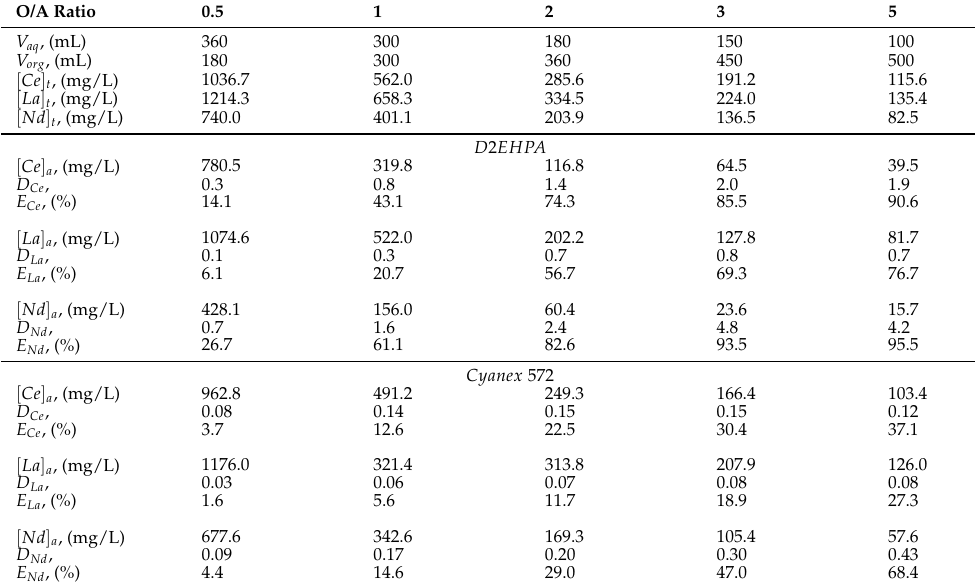
Figure 20. McCabe–Thiele diagrams for the extraction of Ce , La , and Nd with D 2 EHPA at 10% v / v in n-heptane. Table 5. Experimental data for the calculation of the extraction efficiency of Ce , La , and Nd with the change of the O/A